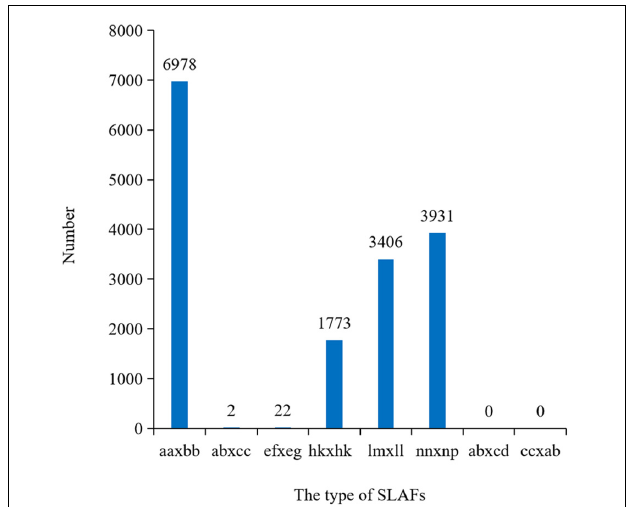
FIGURE 3 | Numbers of SLAFs markers in each segregation types. aa × bb indicated the parents were homozygous; ef × eg, hk × hk, and ab × cd indicated the parents were heterozygosis; lm × ll, nn × np, ab × cc, and cc × ab indicated one of the parents was homozygous and the other was